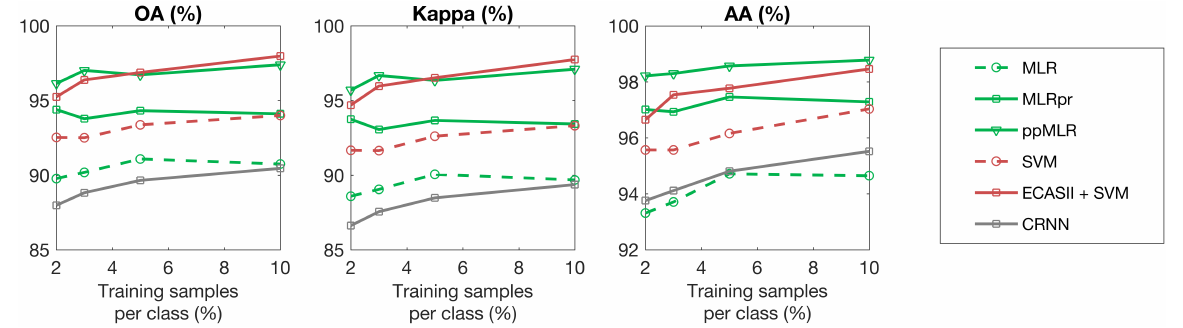
Figure 17. Classification accuracies (%) for different algorithms applied to the Salinas scene using different numbers of training